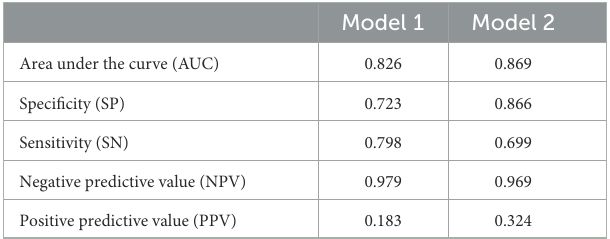
TABLE 6 Receiver operating characteristics (ROC) curve analysis results for models 1 and